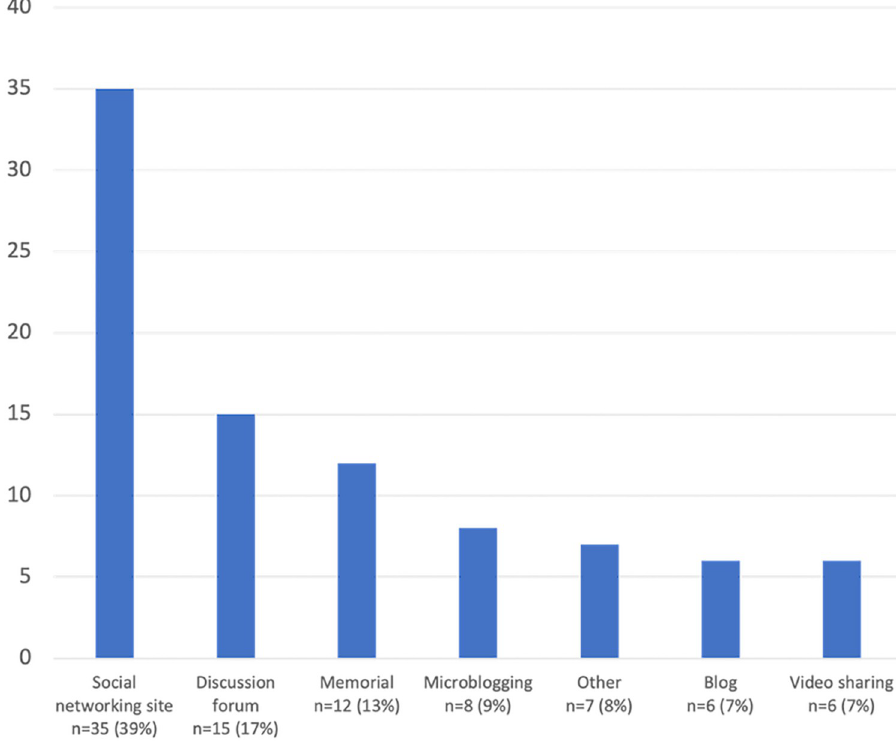
Fig 2. Social media platforms used for data